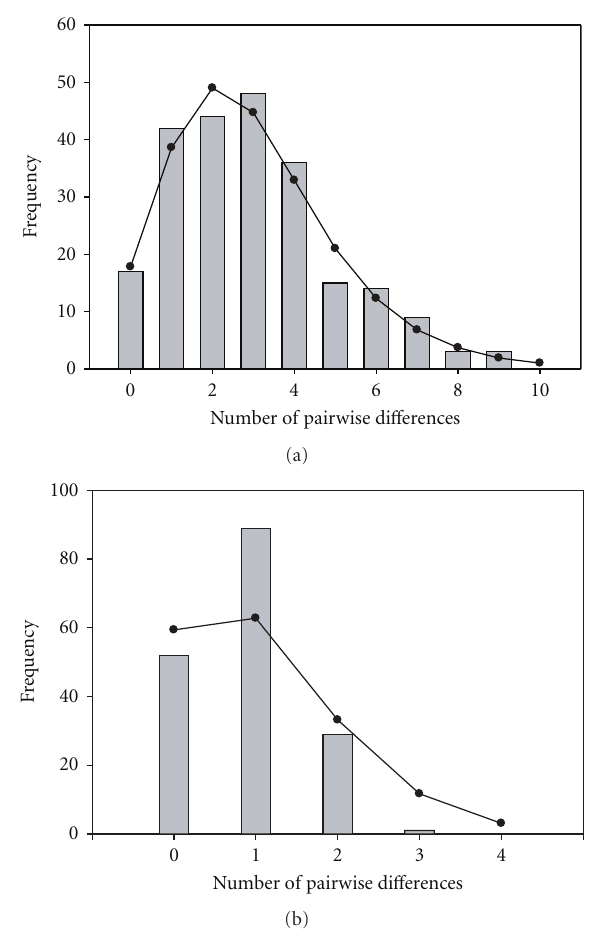
Figure 4: Distribution of pairwise di ff erences among COI haplo- types (mismatch distribution) in populations of Junonia genoveva from Costa Rica (a) and Guaymas, Mexico (b). Solid lines represent the expected distributions under the sudden expansion